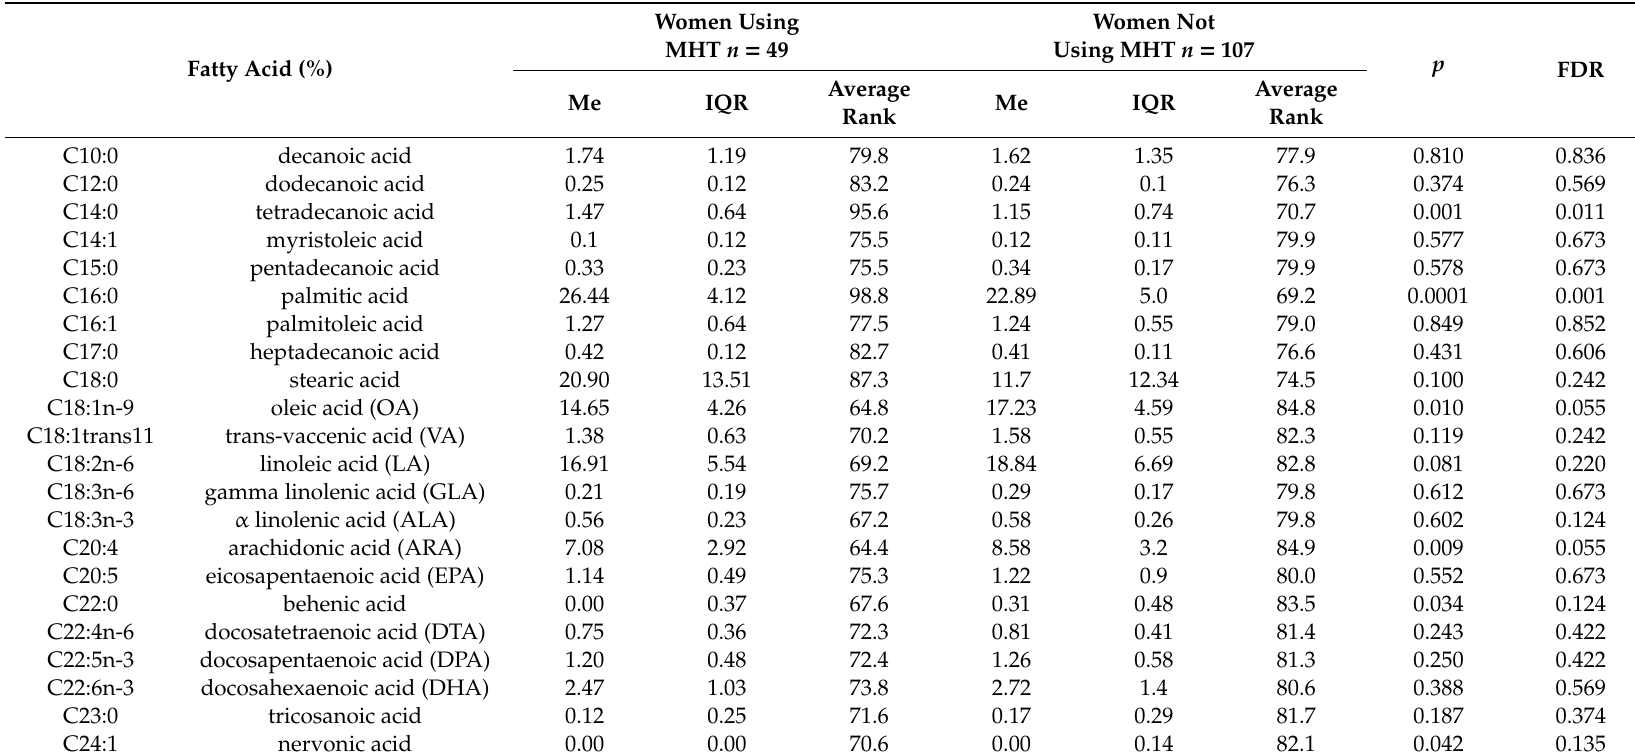
Women Using MHT n = 49